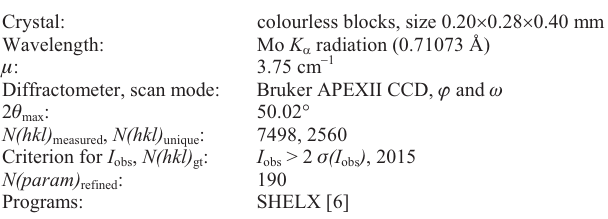
Table 1. Data collection and handling.